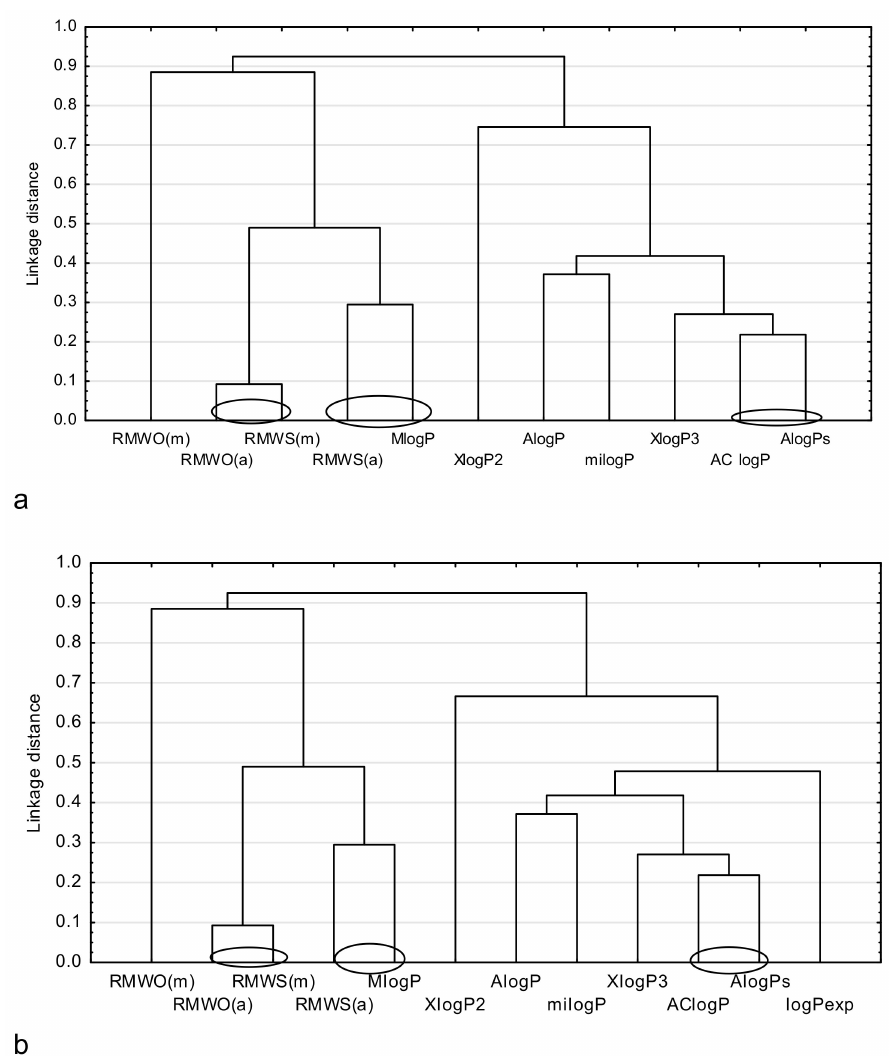
Figure 1. Similarity analysis for antiparasitic drugs, including: ( a ) comparison of the chromatographic and theoretical parameters of lipophilicity. ( b ) comparison of the chromatographic, theoretical and experimental parameters of